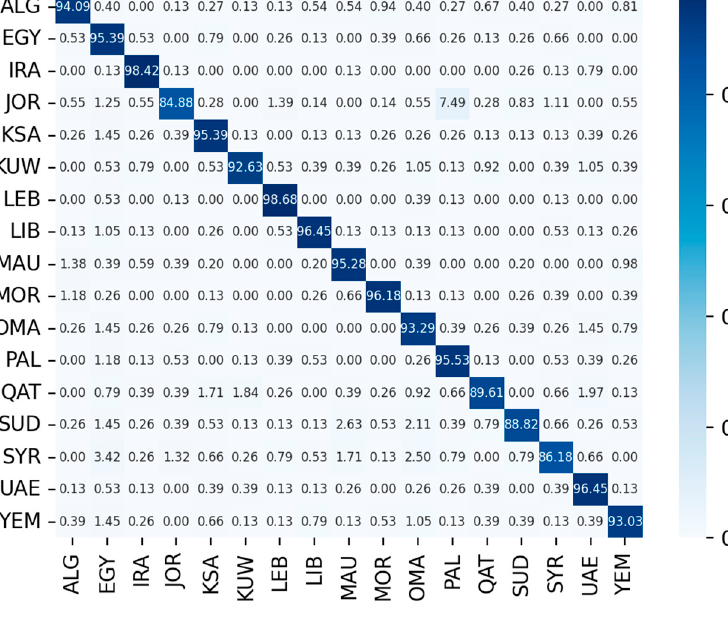
Figure 6. Dialect confusion matrix (balanced fine-tuning).